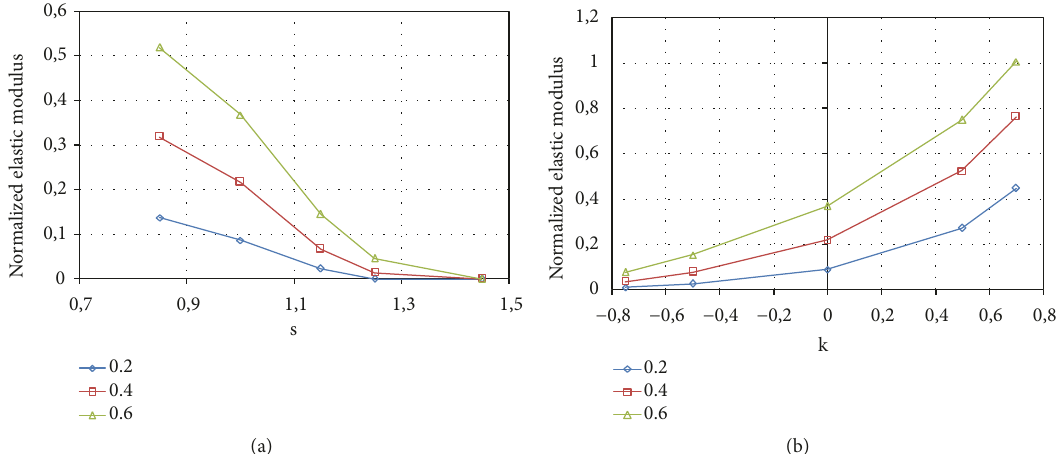
Figure 19: Normalized elastic modulus: (a) solid P-cells with variable s parameter ( 𝑘 = 0 ); (b) solid P-cells with variable k parameter ( 𝑠 = 1 ).